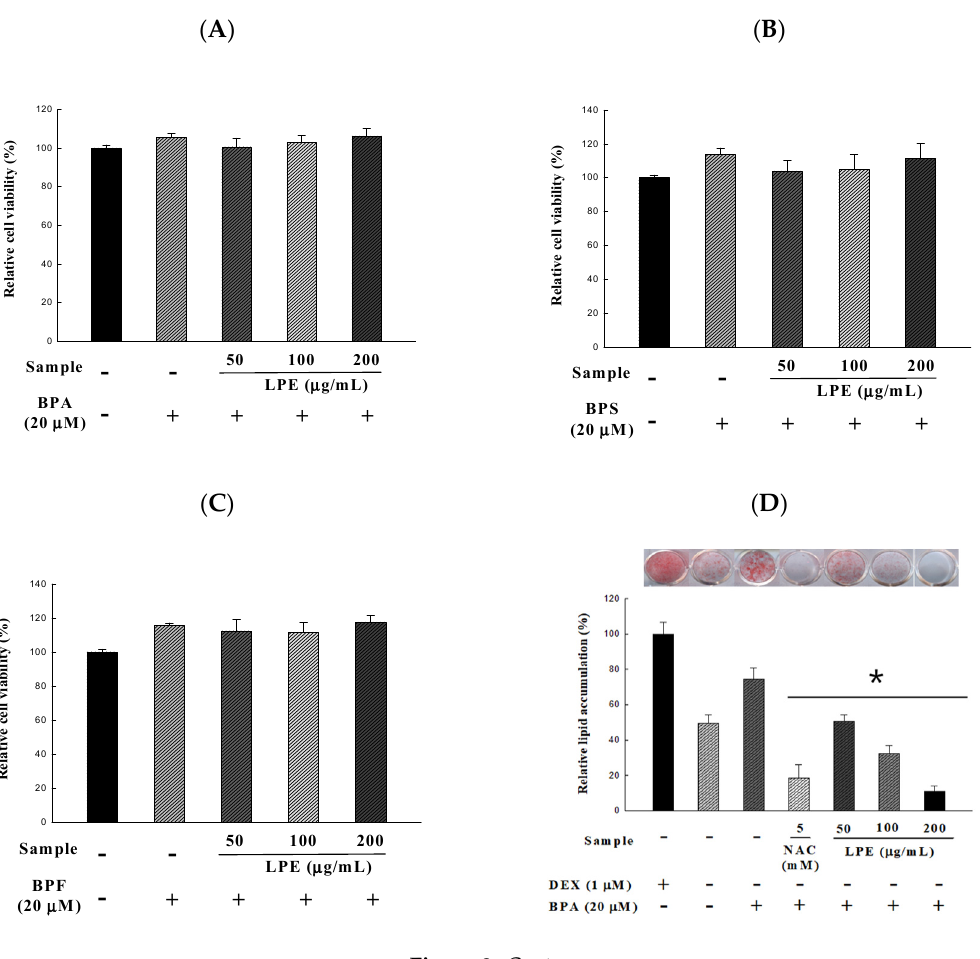
Figure 3. Effects of Potentilla rugulosa Nakai ethanolic extract (LPE) on BPA, BPS, and BPF-induced 3T3-L1 adipocyte in ( A – C ) cell viability and ( D – F ) lipid accumulation were determined by an XTT assay and ORO staining. 20 μ M of BPA, BPS and BPF were treated 6 days before preadipocytes differentiation and maintained during cell differentiation. Various concentrations of LPE were dissolved in DMSO and treated on 3T3-L1 adipocyte (added on day 0 of differentiation) for 10 days. All values are presented as the mean ± SD. * p < 0.05 VS. MI treatment group, according to one-way analysis of variance. 3.5. Effect of LPE on ROS Production in BPA, BPS, and BPF-Induced 3T3-L1 Adipocyte